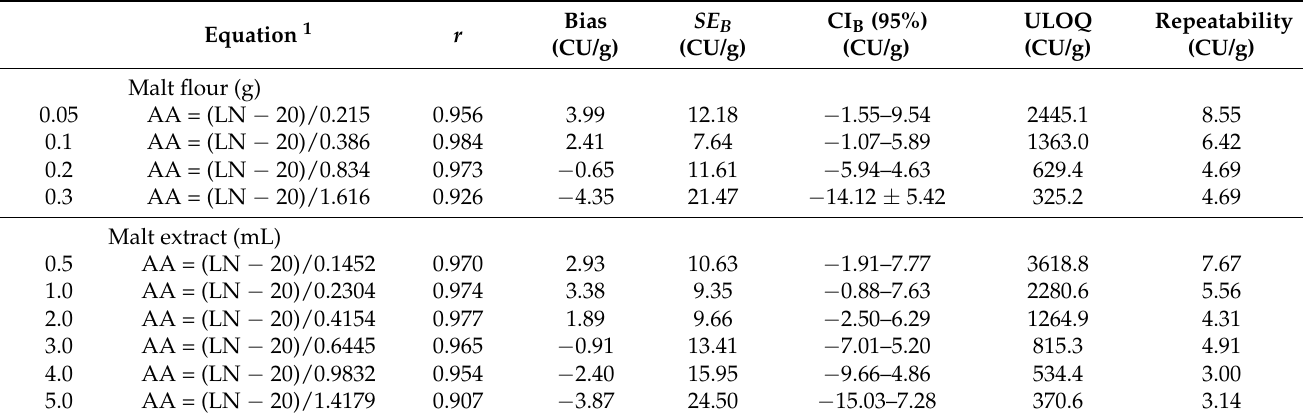
Table 3. Agreement between standard Ceralpha method and modified Falling Number method (linear relationship between Liquefaction Number and α -amylase activity).